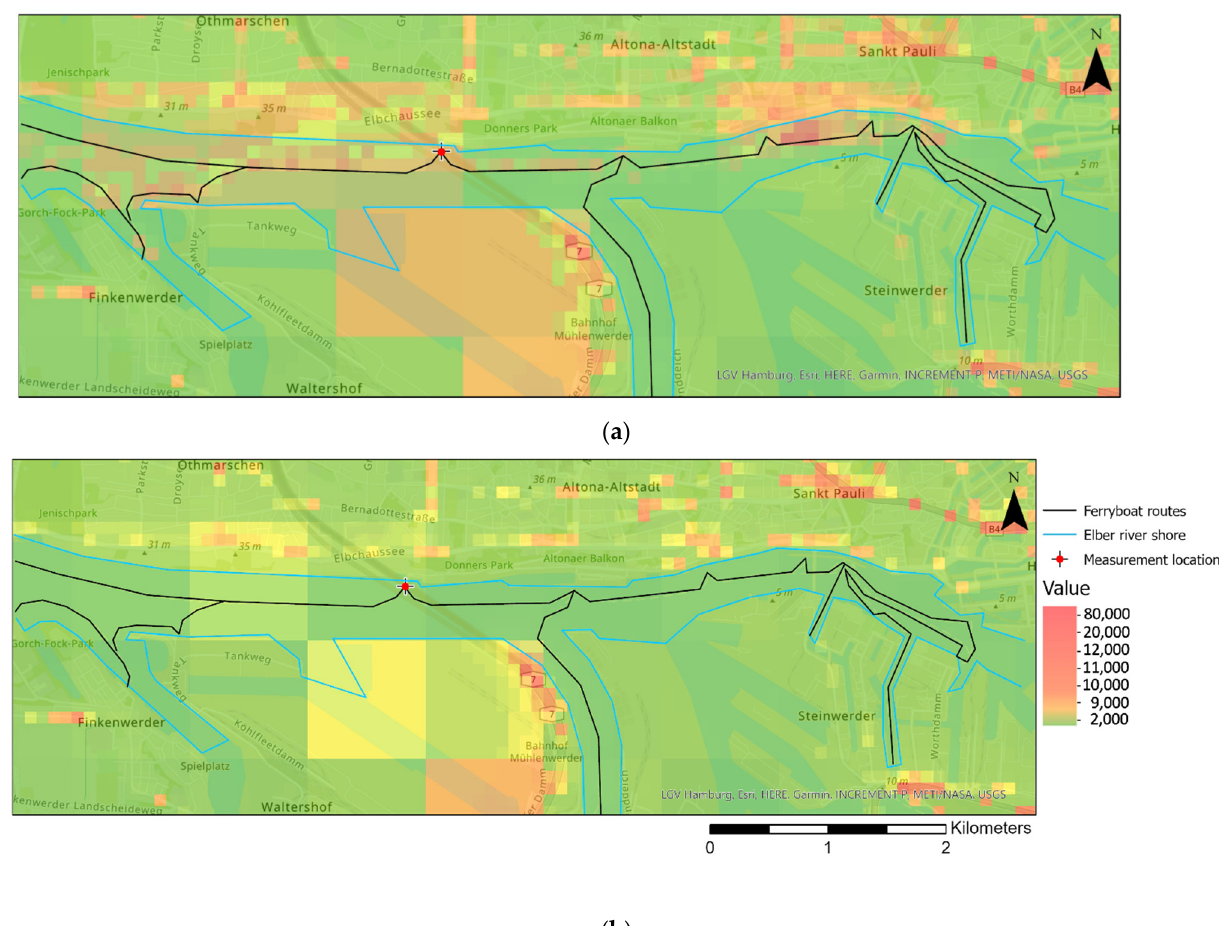
Figure 9. Hourly extract of the PN concentration map for Hamburg on Day 4 (19 February 2021) ( a ) with ferryboat emissions and ( b ) without ferryboat emissions including the Elbe River near the city center as well as the shores. The scale for PN is manipulated for better visualization (see color scale) of the dispersion of ferryboat emissions.